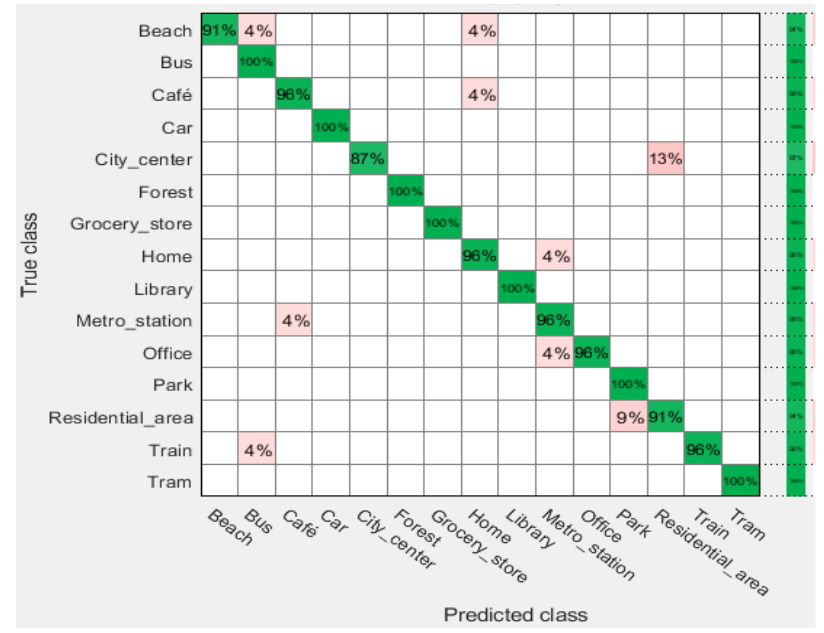
Figure 5: Confusion matrix evaluation on DCASE dataset Figure 7. Confusion matrix of the proposed approach for DCASE dataset.